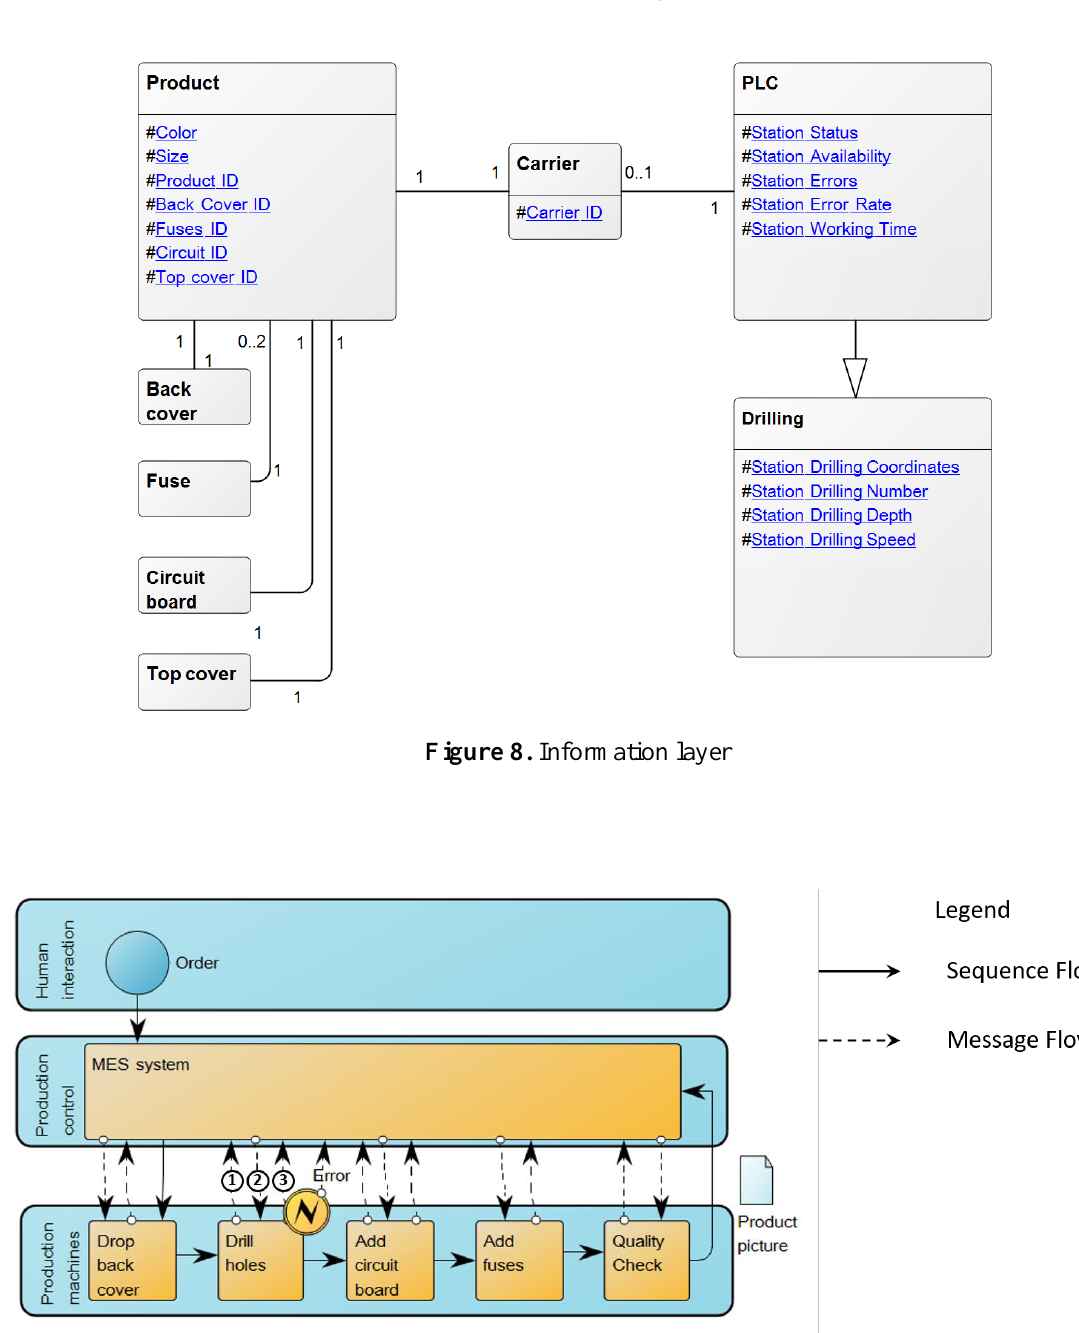
Figure 9. Communication